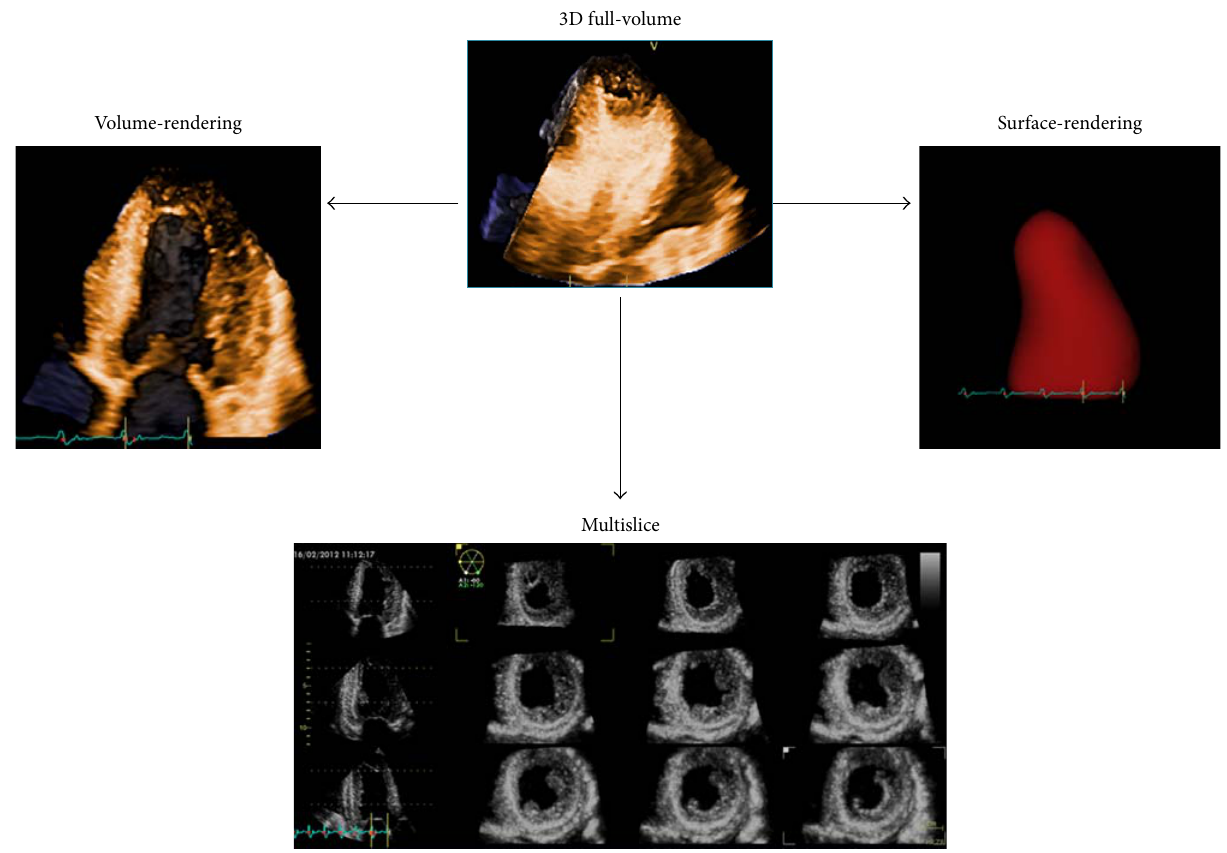
Figure 7: From the same pyramidal three-dimensional data set, the left ventricle can be visualized using different display modalities: volume rendering, for visualizing morphology and spatial relationships among adjacent structures; surface rendering, for quantitative purposes; and multislice (multiple two-dimensional tomographic views extracted automatically from a single 3D data set) for morphological and functional analysis at different regional